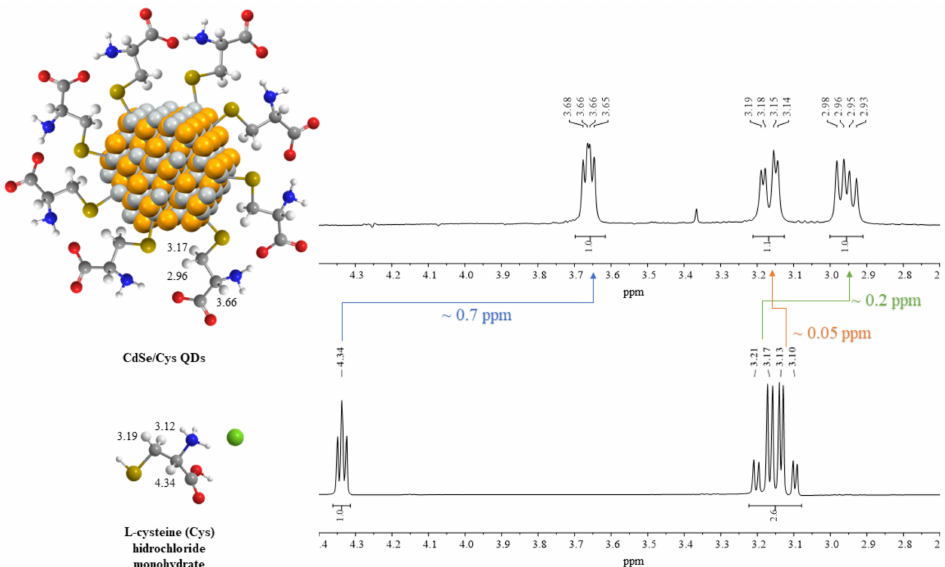
Figure 4. 1 H NMR spectrum (in D 2 O) of cysteine-capped CdSe QDs ( top ). The spectrum of L-cysteine ( bottom ) has been included for